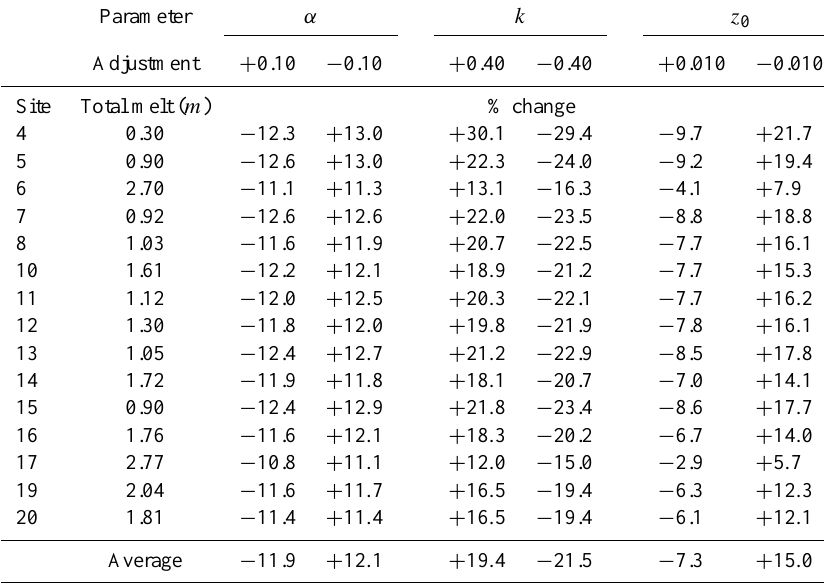
Table 5. Sensitivity analysis showing percent changes relative to the total melt ( m ) as a function of the uncertainty associated with the cali- brated parameters ( α , k , z 0 ) for all sites over the study period using the LE Rain model in conjunction with the average calibrated parameters for all